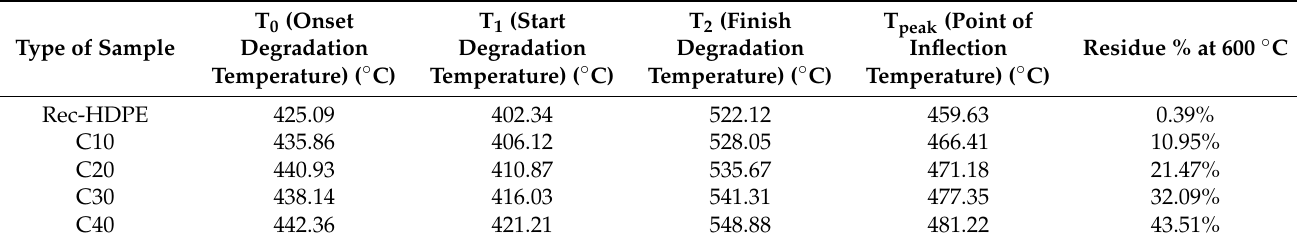
Table 5. Thermal properties of the recycled HDPE and